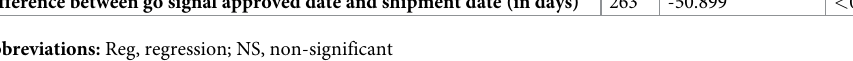
on effective usage. The hypothesis is that extending information sharing may have a positive impact on the downstream processes that are actively displayed in the public country pages, which provides country managers with shipment, arrival, and delivery statuses. Table 4 pro- vides the analysis results to answer the second research question regarding the impact of mak- ing country-level data publicly accessible. The results show three variables with significant, positive association: shipment timeliness, arrival timeliness, and delivery timeliness—consistent with the hypothesis that these variables would be impacted since they are actively displayed in these publicly accessible pages. In the main regression results, shipment timeliness and arrival timeliness did not show any signifi- cance from the information sharing. In these results, shipment timeliness is significant at a p - value of 0.001 and with a substantial coefficient of 2.57. Arrival timeliness is significant with a p -value of 0.003 and a coefficient of 2.88. Lastly, the important delivery timeliness performance indicator is also significant with a p -value of 0.011 and a coefficient of 2.82. We also conducted further analyses to check the robustness of the results (see S4 Table).